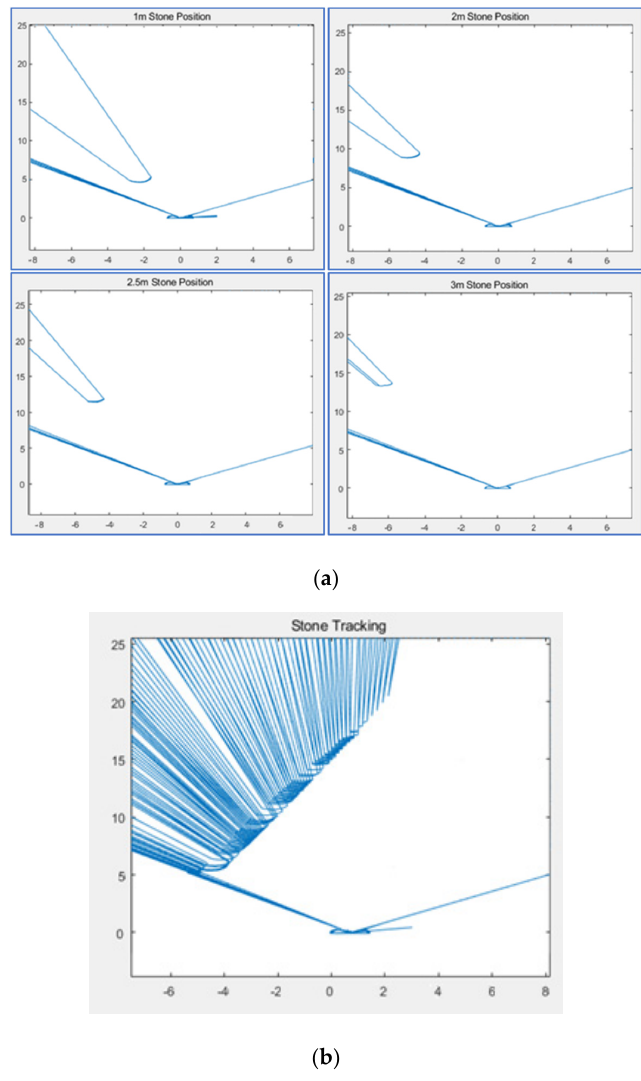
Figure 6. Experiment on curling stone measurements in an actual curling field.